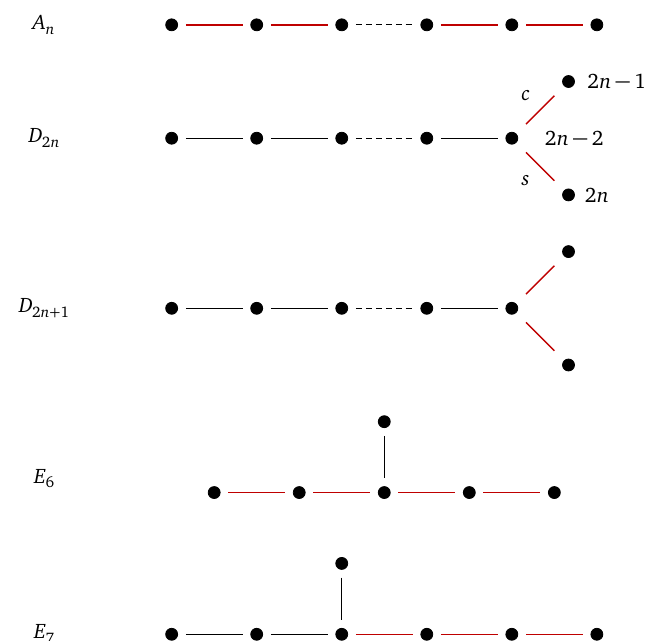
Figure 6: We mark in red the edges in the Dynkin diagrams (identically labelled as those in section 3.1.1) which correspond to points of intersection between to rational curves at which a thimble can end. There are two thimbles for the case D with the co-spinor, spinor representation. We labelled the edges at which these attach to by c , s